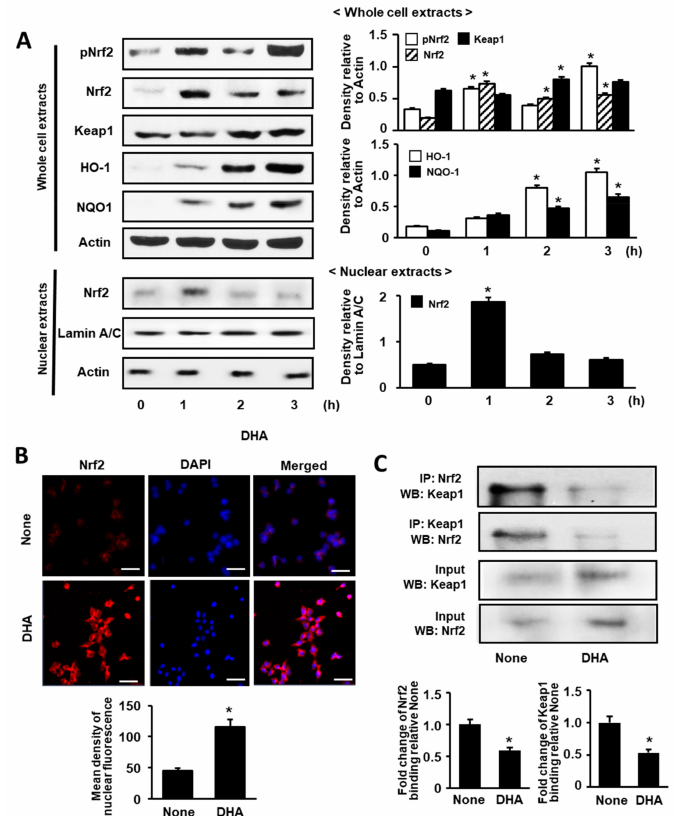
Figure 1. E ff ect of DHA on the levels of activated Nrf2, Nrf2, Keap 1, HO-1, NQO1, and Keap 1-bound Nrf2 in AR42J cells. ( A ) Cells (8.0 × 10 5 / dish) were treated with 50 µ M DHA for the indicated time periods. Protein levels were determined by Western blot analysis in whole-cell extracts (upper panel) or nuclear extracts (lower panel) with actin as the loading control and lamin A / C as the index for the nuclear extracts. The densitometry data represent means ± S.E. from three immunoblots and are shown as relative density of protein band normalized to actin or lamin A / C level. ( B ) Nuclear translocation of Nrf2 was determined with confocal microscope images of AR42J cells (2 × 10 5 / well) treated with 50 µ M DHA for 1 h followed by immunofluorescence staining of the fixed cells (upper panel). Nrf2 was visualized using fluorescein / rhodamine-conjugated anti-rabbit IgG antibody (red) with DAPI counter staining (blue) of the same field. “None” refers to cells treated with the vehicle for DHA (0.5 M ethanol) only. The scale bar was 50 µ m. The intensity of NRF2 red fluorescence in the nuclei was quantified (lower panel). Values represent the means of three independent experiments. ( C ) Cells (8 × 10 5 / dish) were treated with 50 µ M DHA for 1 h. Interaction between Nrf2 and Keap1 was determined by Western blots of whole-cell extracts and whole-cell extract-derived immunoprecipitates obtained using the anti-Nrf2 and anti-Keap 1 antibodies for precipitation (IP) and visualization (WB; Western blot analysis), as indicated (upper panel). Input is used as the control for protein expression. “None” refers to cells treated with the vehicle for DHA (0.5 M ethanol) only. Quantification of binding of Nrf2 to keap1 or binding of Keap1 to Nrf2 is based on band intensity of Western blot analysis using Image J software (lower panel). The densitometry data represent means ± S.E. from three immunoblots. * p < 0.05 vs.